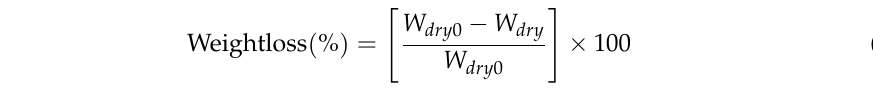
Figure 2. Histograms of the PGA domains diameter in the PLLA-based blends: ( a ) PLLA70/PGA30, ( b ) PLLA80/PGA20, and ( c ) PLLA90/PGA10.